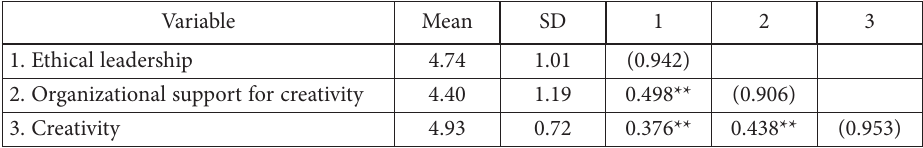
Table 2. Mean, standard deviations, and correlations (source: created by authors)